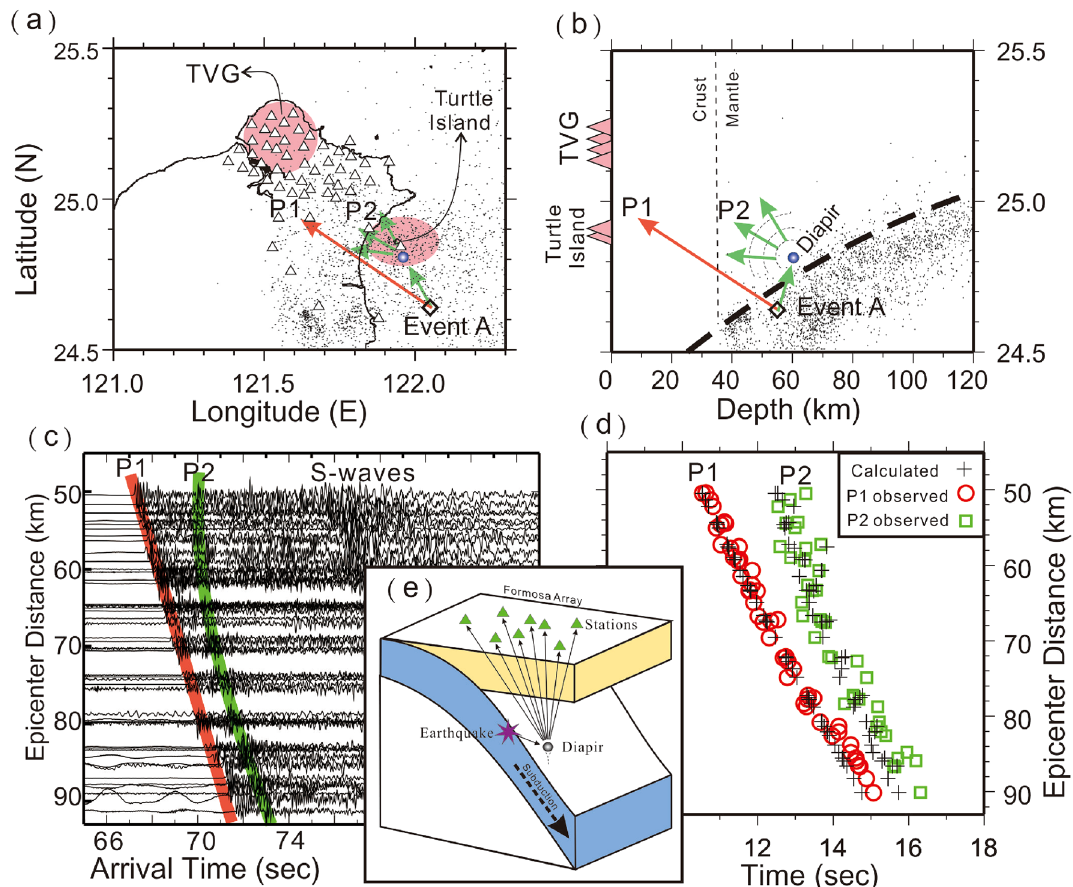
Figure 4. Locations of seismic stations (triangles), Event A (diamond) and diapir (blue circle) on the map ( a ) and depth profile ( b ). Locations of two active volcanoes, the Tatun volcano group (TVG) and Turtle Island are marked in pink. ( c ) The arrivals of P1 and P2 are, respectively, marked in red and green on the vertical seismograms plotted with epicentral distances. ( d ) The comparison between the observed arrivals of P1 (red circles) and P2 (green squares), and their calculated arrivals (pluses). ( e ) A schematic plot showing the ray-paths scattered from the diapir in the mantle wedge. This figure was partially created by Generic Mapping Tools